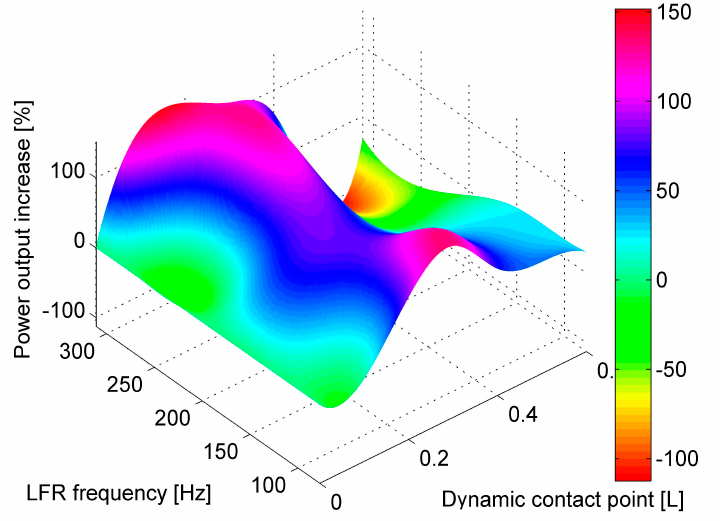
Figure 7. Comparison of RMS power output at different contact points with respect to PVEH power output when dynamic contact point is at 0 L.